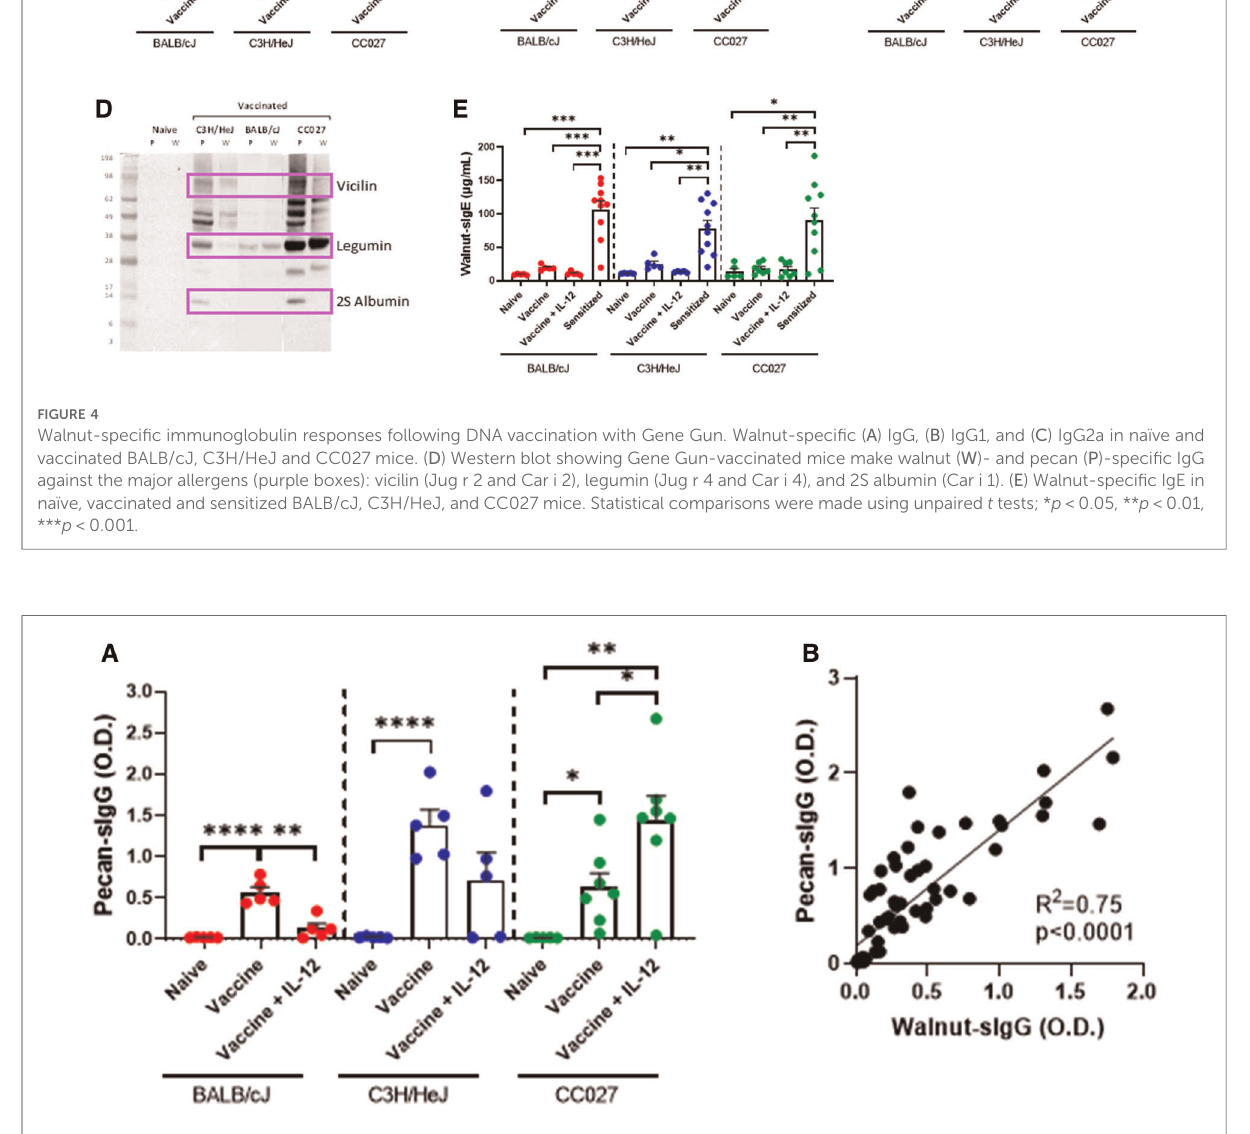
In mice, vaccines were transcutaneously administered by Gene Gun twice, three weeks apart, to prime and then boost the immune response. DNA plasmids were administered alone, or in combination with a mouse IL-12 plasmid